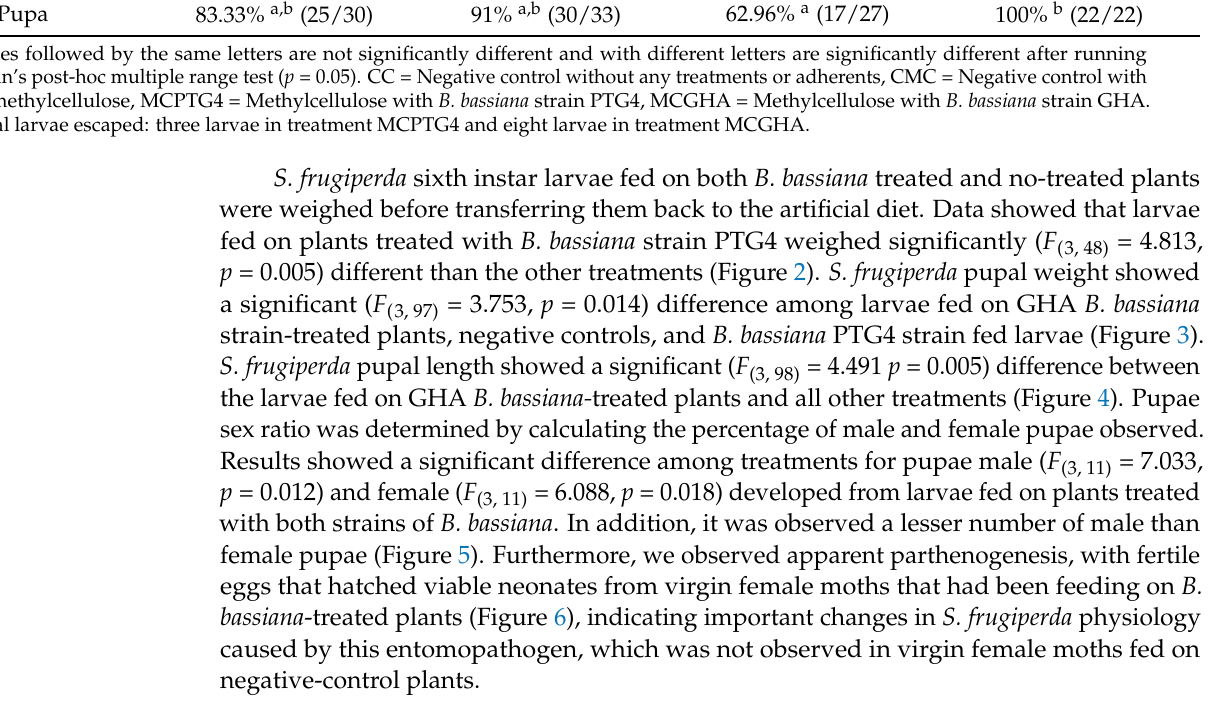
Figure 3. S. frugiperda pupal weight after feeding on the plants from the speci- fied treatments. CC: Negative control, CMC: Negative control with only methylcellulose, MCPTG4: B. bassiana fungal strain PTG4 with methylcellu- lose, MCGHA: B. bassiana fungal strain GHA with methylcellulose. Analysis done with Duncan’s post-hoc multiple range test ( α = 0.05) after one-way ANOVA. Graphical bars with the same letters indicate that there were no sig- nificant differences among them.